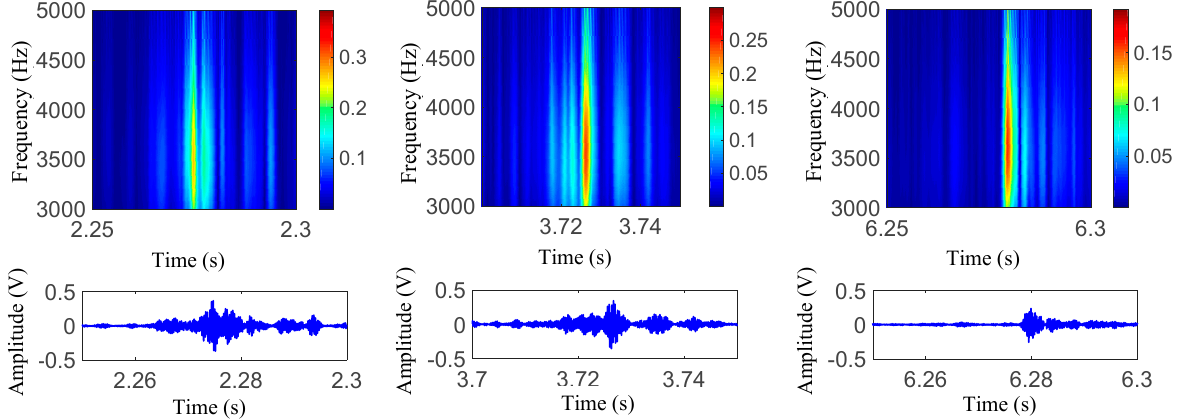
Figure 11. Wavelet analysis examples for impact vibration of sensor 1 under a 12 km/h velocity.